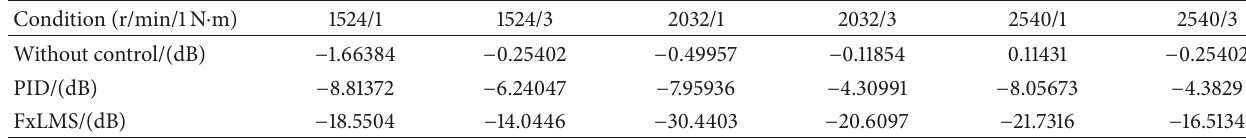
Table 4: The comparison results of Figure 10.